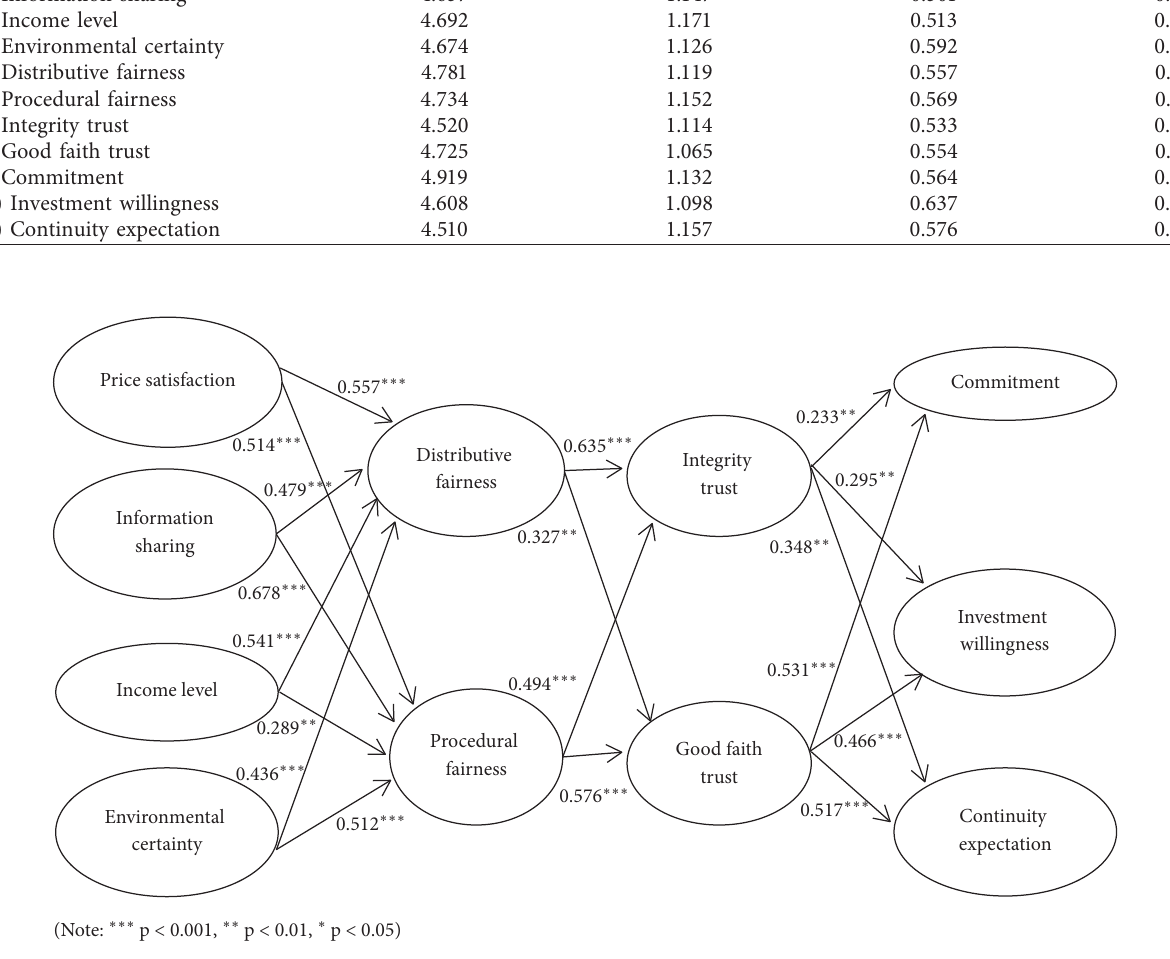
Figure 2: Model path analysis